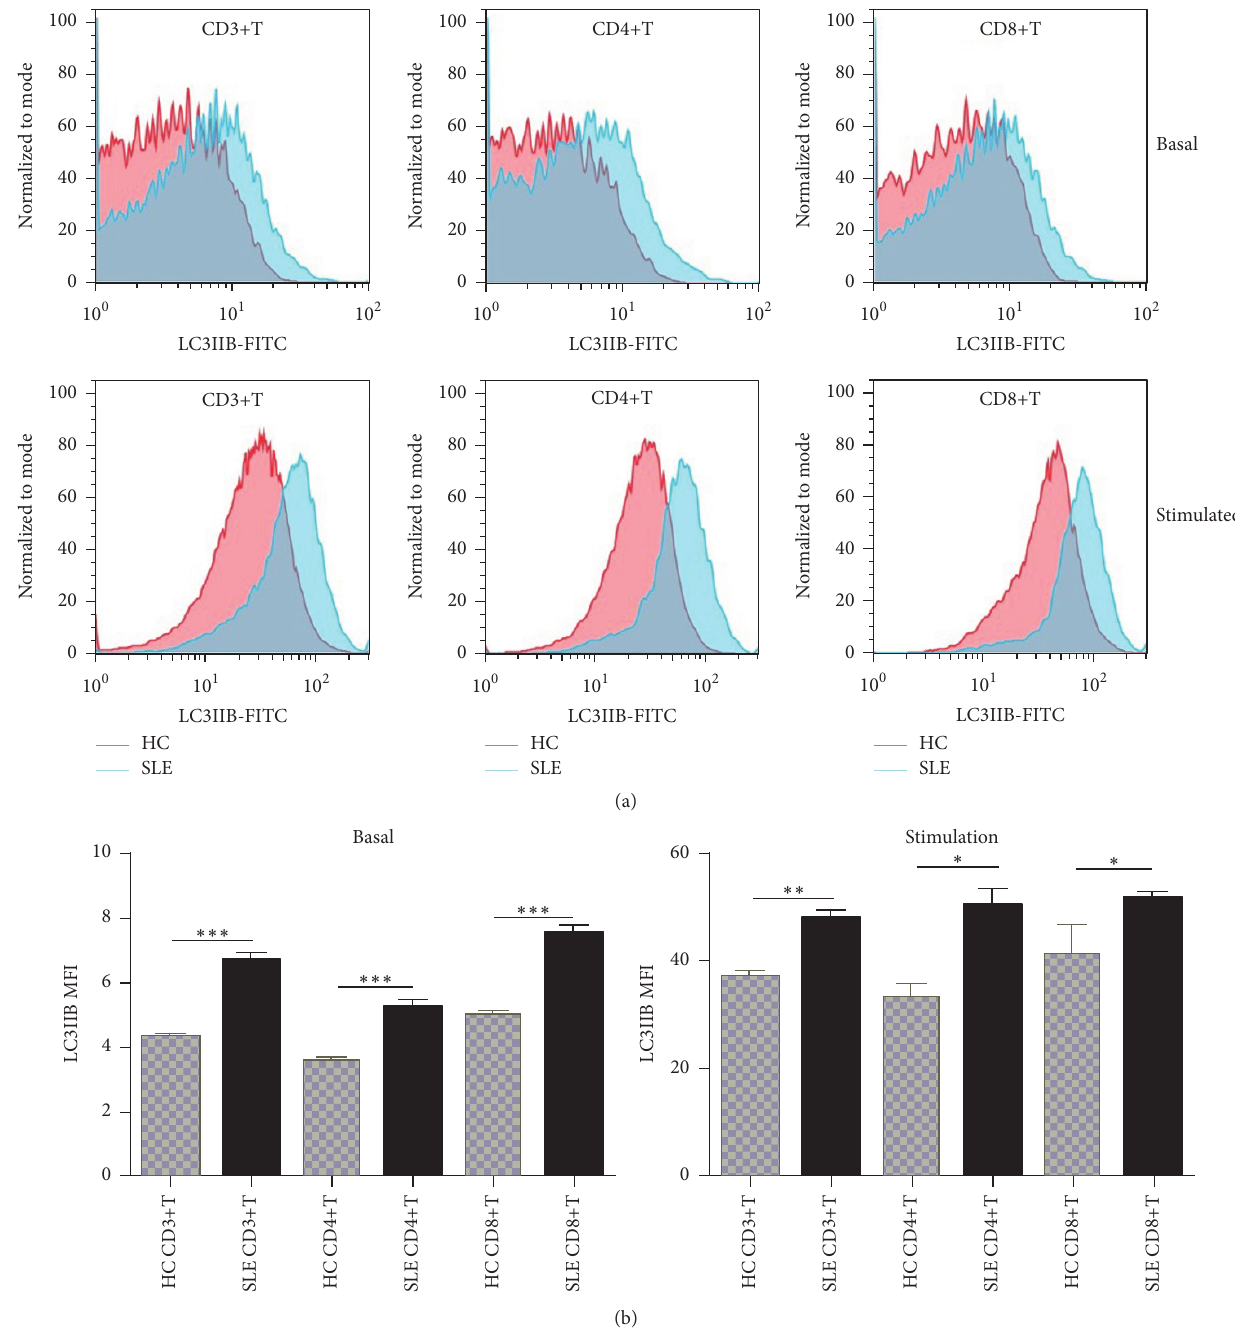
Figure 2: T cells from SLE patients had overactivated autophagy. PBMCs were stimulated with or without anti-CD3/CD28 antibodies (3 𝜇 g/mL) for 3 days. In vitro experiments were performed in triplicate. ((a), (b)) Basal autophagy of T cells from SLE patients ( 𝑛 = 9 ) was higher than that from healthy controls ( 𝑛 = 5 ) and further increased after anti-CD3/28 stimulation. The number of T cells was normalized to mode. ∗ 𝑝 < 0.05 ; ∗∗ 𝑝 < 0.01 ; ∗∗∗ 𝑝 < 0.001 . dependent (Figure 6(d)). However, AMPK activation of T cells with RSVA314 abrogated UC-MSCs’ inhibition on T cell apoptosis ( 29.50 % ±5.58 % versus 13.57 % ±7.31 %, 𝑝 =